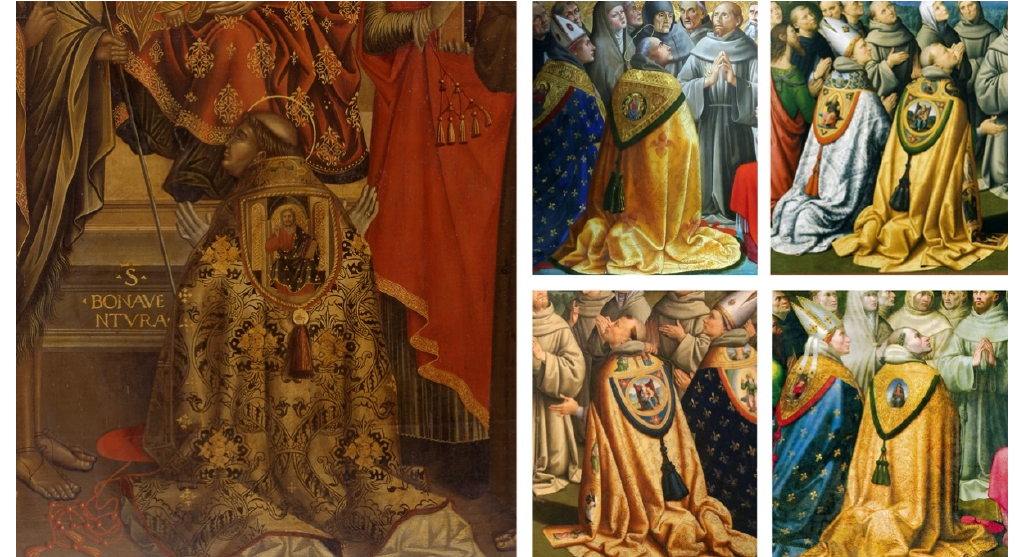
Figure 12. Angelos Bitzamanos, Saint Bonaventure (detail from the Scottivoli altarpiece), 1508, Apostolic Palace, Vatican ( left ) © Musei Vaticani. Reproduced with permission; Domenico Ghirlandaio, Saint Bonaventure (detail from the Coronation of the Virgin), 1486. Museo Eroli, Narni; Lo Spagna. Saint Bonaventure (detail from the Coronation of the Virgin), 1511. Todi, Museo Civico e Pinacoteca; Lo Spagna. Saint Bonaventure (detail from the Coronation of the Virgin), 1522. Trevi, Pinacoteca Civica—Complesso Museale di San Francesco; Jacopo Siculo. Coronation of the Virgin, 1541, Former Church of Saint Francis, Norcia (from left to right ). Images in the public domain; Figure created by author.